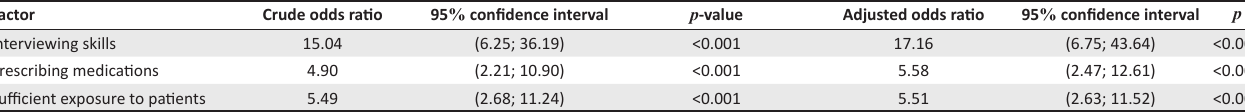
TABLE 4: Crude and adjusted odds ratios for other factors associated with students’ perception of preparedness for their careers. Factor Crude odds ratio 95 % confidence interval p -value Adjusted odds ratio 95 % confidence interval p Interviewing